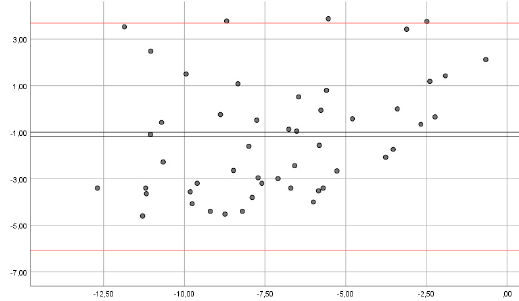
Figure 7. Bland–Altman plots comparing results between systems (Kinovea and Vicon) for the hip ankles ( a ), knee angles ( b ) and ankle angles ( c ). Bias (black line) and limits of agreement (red lines) are shown for each parameter. The mean score is plotted on the x -axis, and the difference between systems (mean of the differences) is plotted on the y -axis (mean difference ± 1.96 SD).